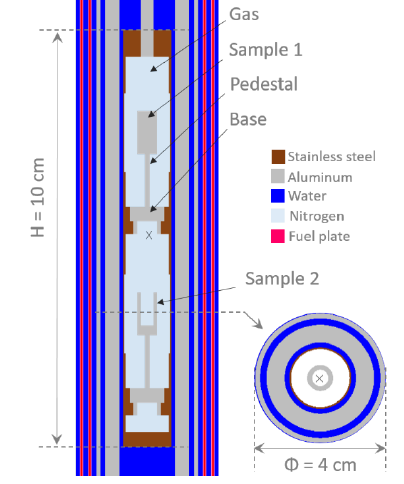
Fig. 7. TRIPOLI-4® geometry modelling of CARMEN's calorimeter.